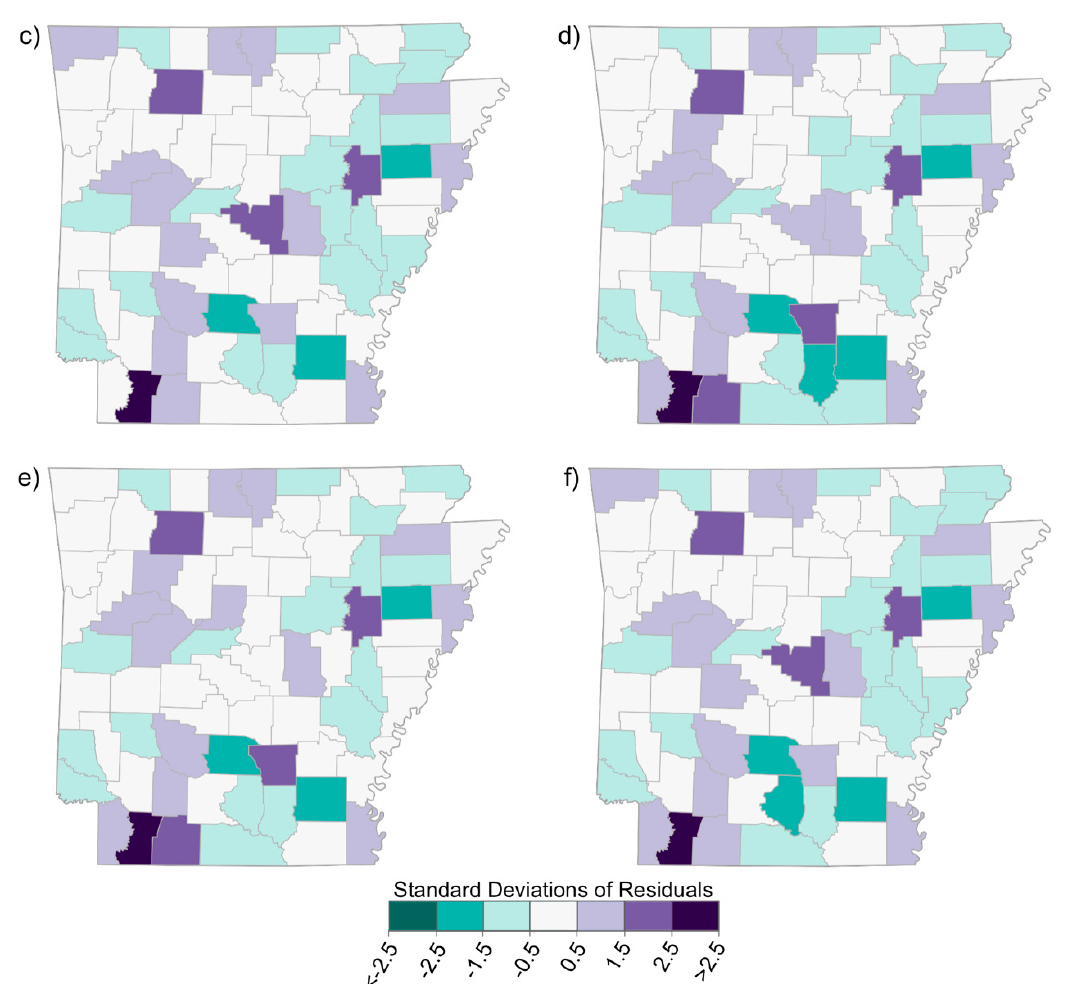
Figure 5. Distribution of residuals from geographically weighted regressions of selected chemicals, demographic variables, and colorectal cancer incidence: ( a ) 2,4-D, salts and esters; ( b ) carbon tetra- chloride; ( c ) carbon disulfide; ( d ) ethylene dibromide; ( e ) methyl bromide; and ( f ) trifluralin.